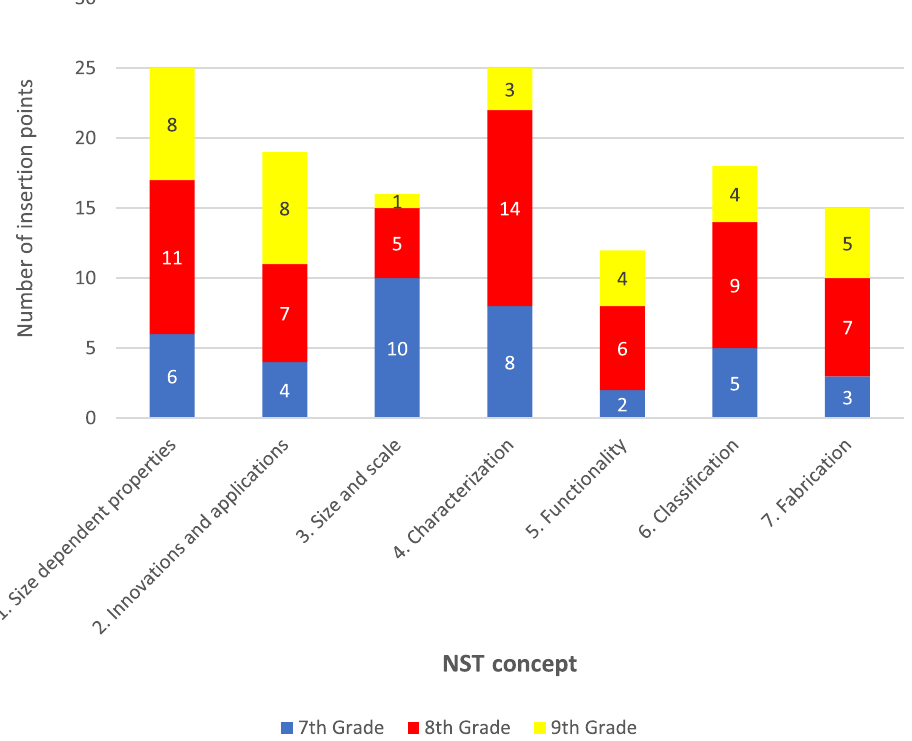
FIG. 3. The sum of insertion points for each NST concept in the middle school physics curriculum according to grade (obtained from 12